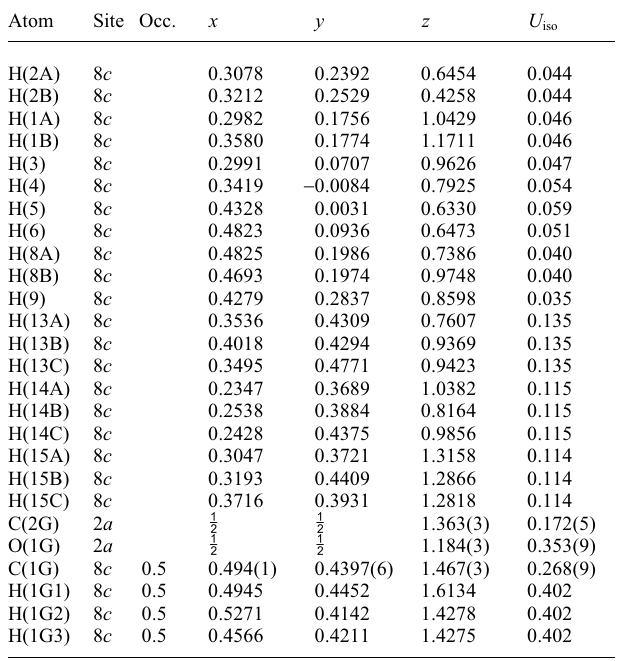
Table 2. Atomic coordinates and displacement parameters (in Å 2 )